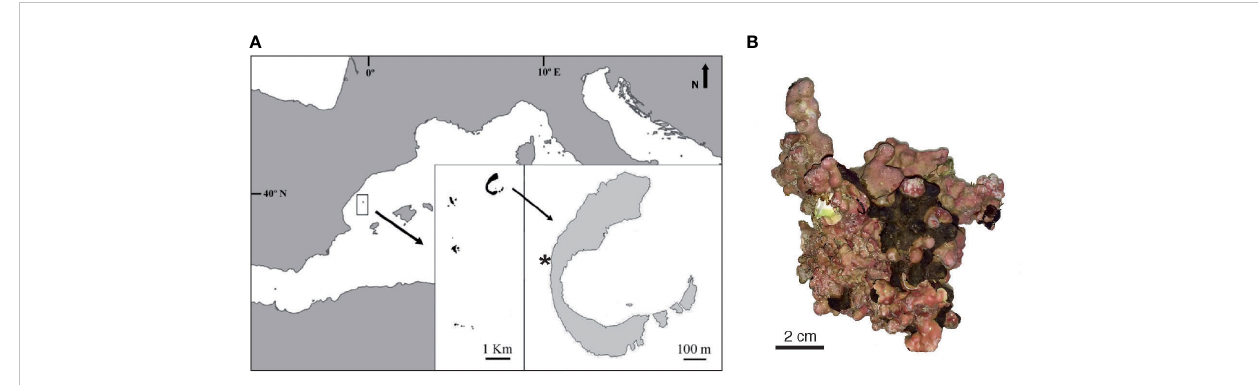
FIGURE 1 Study site and coralline algal sample. (A) Map of study site Columbretes Islands (Spain) in Mediterranean Sea. Inset shows crescent-shaped Illa Grossa Bay (39°53.825 ′ N, 0°41.214 ′ E), where coralline algae were sampled in October 2017 (by DK) and where water temperature monitoring sensors are installed (*). (B) Attached-living specimen of Neogoniolithon hauckii . Map (A) modi fi ed after Kersting et al.